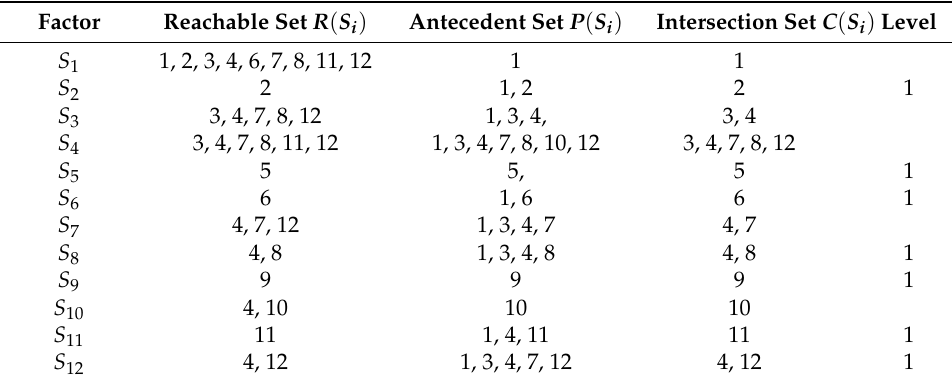
Table 7. Reachable set and antecedent set of